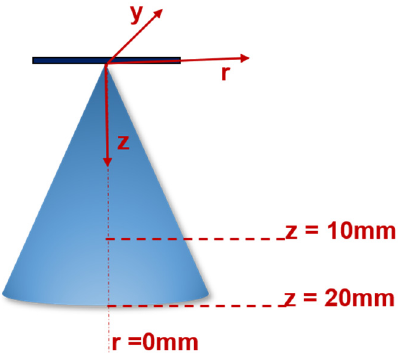
Figure 4. System of coordinates used in the measurements with the phase Doppler interferometer.